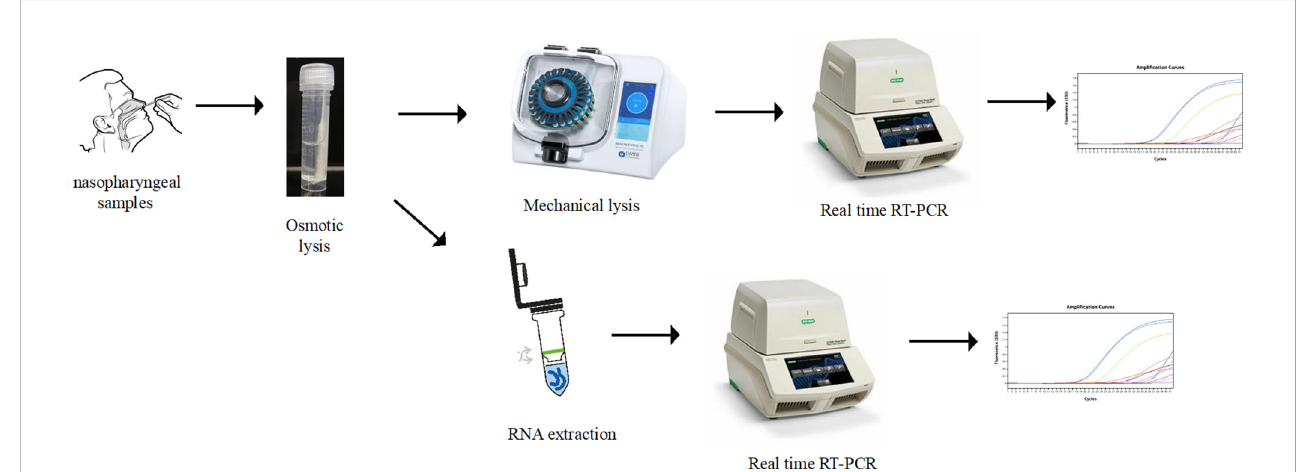
FIGURE 1 Flow chart for nasopharyngeal samples processing for SARS-CoV-2 detection by RT-qPCR for the regular RNA extraction method and for the RNA extraction free protocol based on mechanical lysis with a